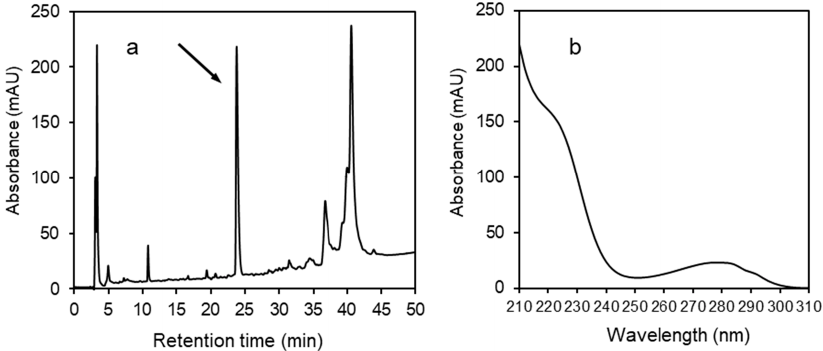
Figure 1. ( a ) An example of an RP-HPLC profile of joint fluid at 220 nm. The arrow indicates the peak representing the combination of three human α -defensins (HNP-1, HNP-2, and HNP-3). ( b ) The characteristic UV spectrum of α -defensins.